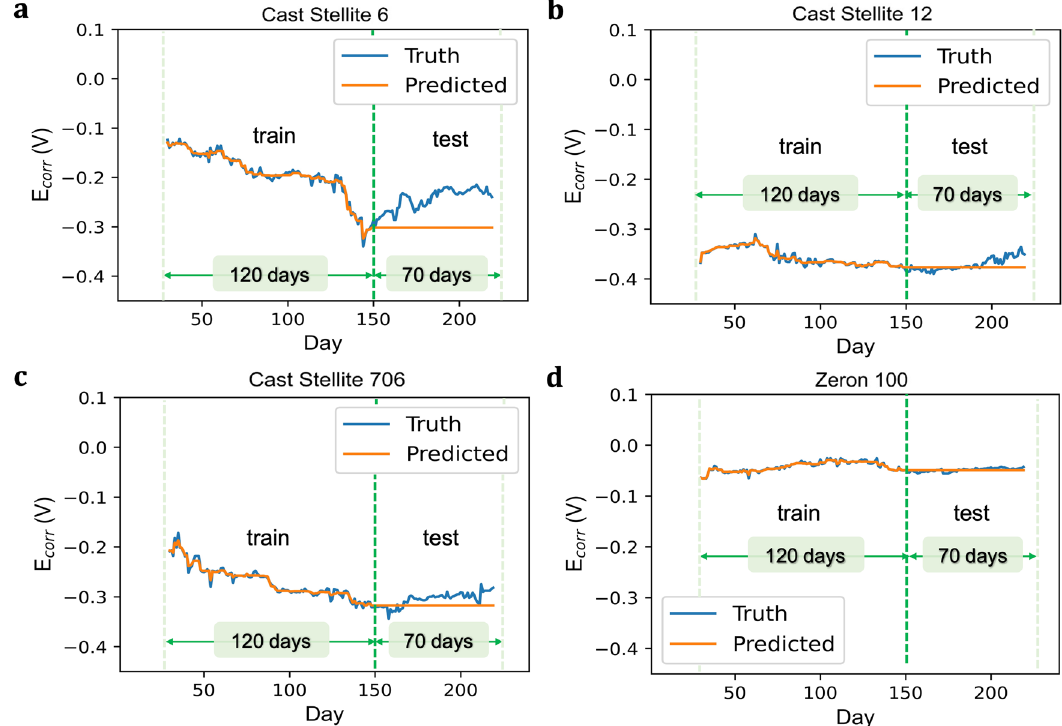
Fig. 7 The prediction of following 70 days ’ immersion by GBR model. Prediction of the following 70 days of immersion by the GBR model: a Cast Stellite 6, b Cast Stellite 12, c Cast Stellite 706, and d Zeron 100. GBR gradient boosting regression, Ecorr free corrosion